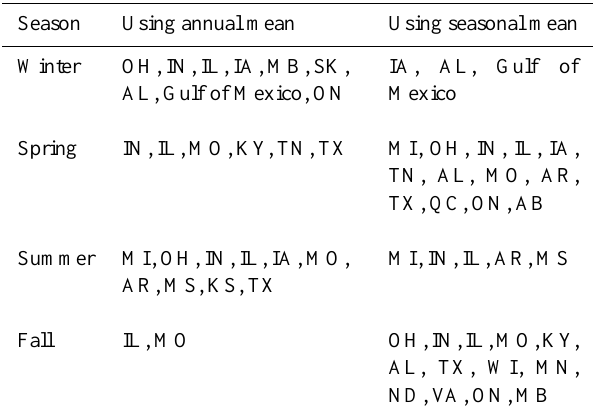
Table 2. Source regions responsible for high TGM concentrations in